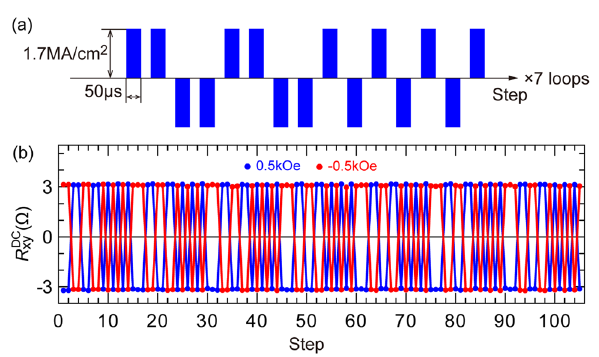
Figure 6. Robust SOT magnetization switching by YPtBi in sample E. ( a ) Sequence of 105 pulses with the current density in YPtB of 1.7 × 10 6 Acm −2 and the pulse width of 50 μs. ( b ) Hall resistance data measured for a total of 210 pulses under a bias field of ± 0.5